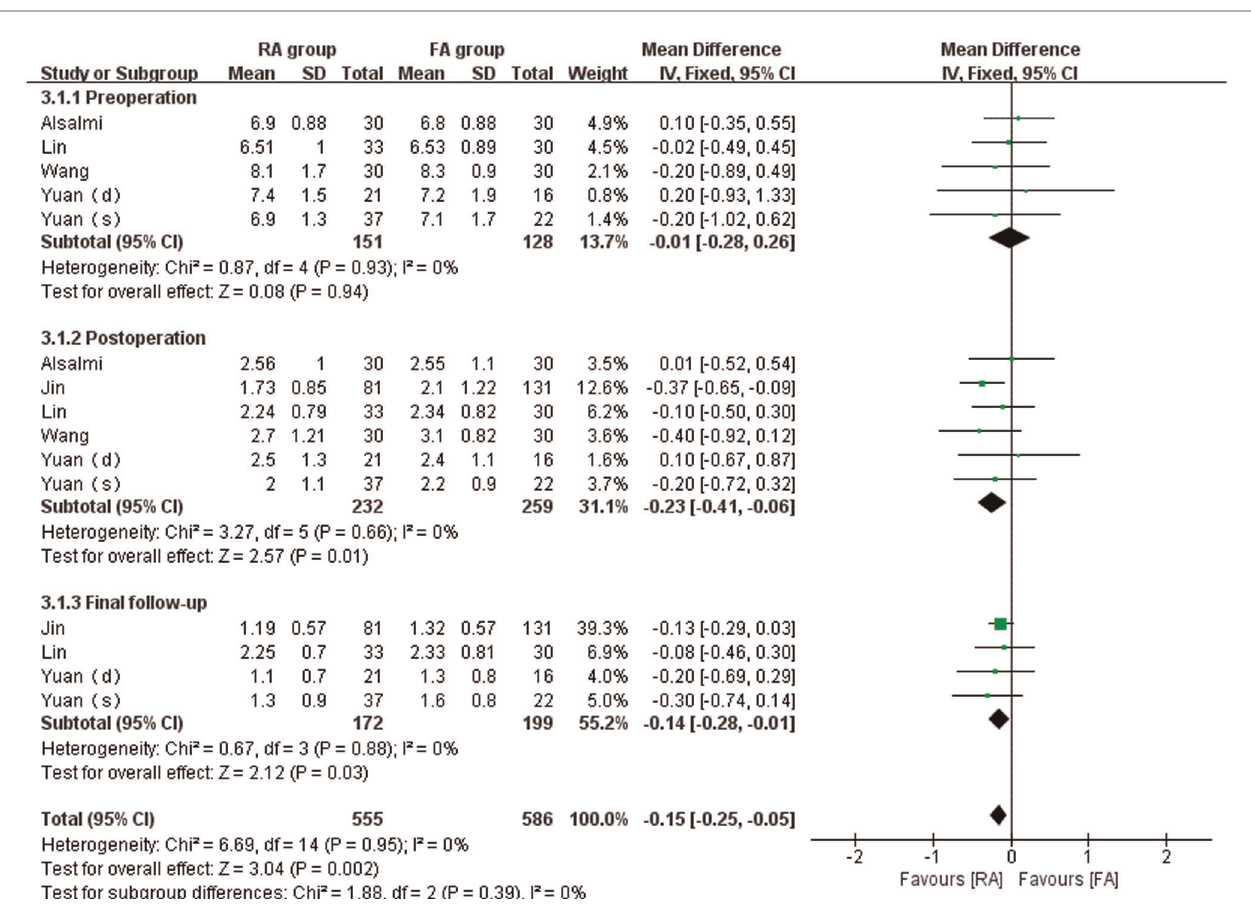
FIGURE 4 | Forest plot depicting WMDs of the VAS scores for back pain.